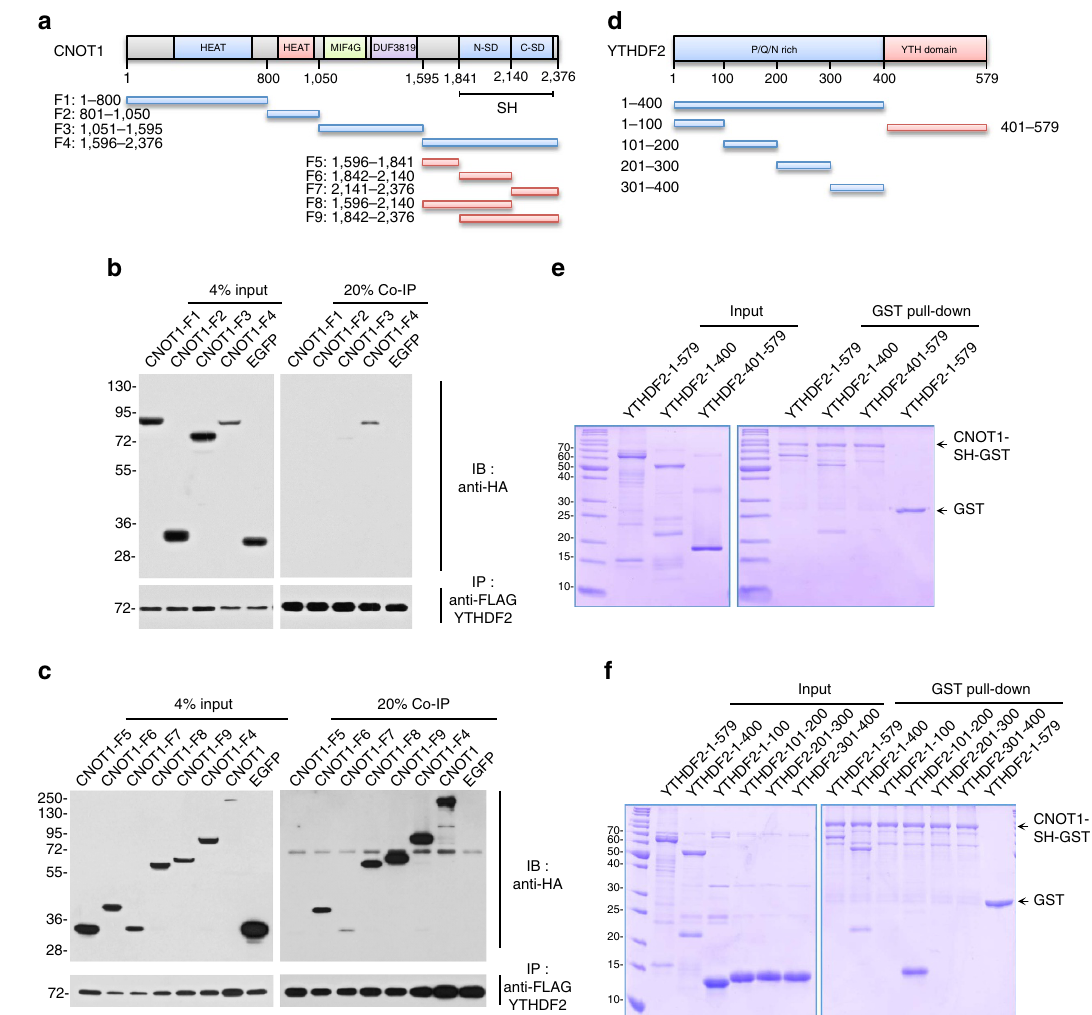
Figure 4 | The SH domain of CNOT1 directly interacts with YTHDF2. ( a ) Schematic diagram of human CNOT1 and the fragments used in b and c . ( b , c ) Interaction between YTHDF2 and CNOT1 fragments. HEK 293 cells were co-transfected with a plasmid encoding FLAG-tagged YTHDF2 and an HA-tagged CNOT1 fragment or a negative control (EGFP). Immunoprecipitation and immunoblotting were performed as in Fig. 3a–c. ( d ) Schematic diagram of human YTHDF2 and the fragments used in e and f . ( e , f ) Determination of a direct interaction between CNOT1-SH and YTHDF2 fragments by GSTpull- down assays. Recombinant His-tagged YTHDF2 or its fragments and GST-tagged CNOT1-SH were purified, and equal amounts of both proteins were subjected to GST pull-down assay followed by SDS–PAGE separation and Coomassie Blue